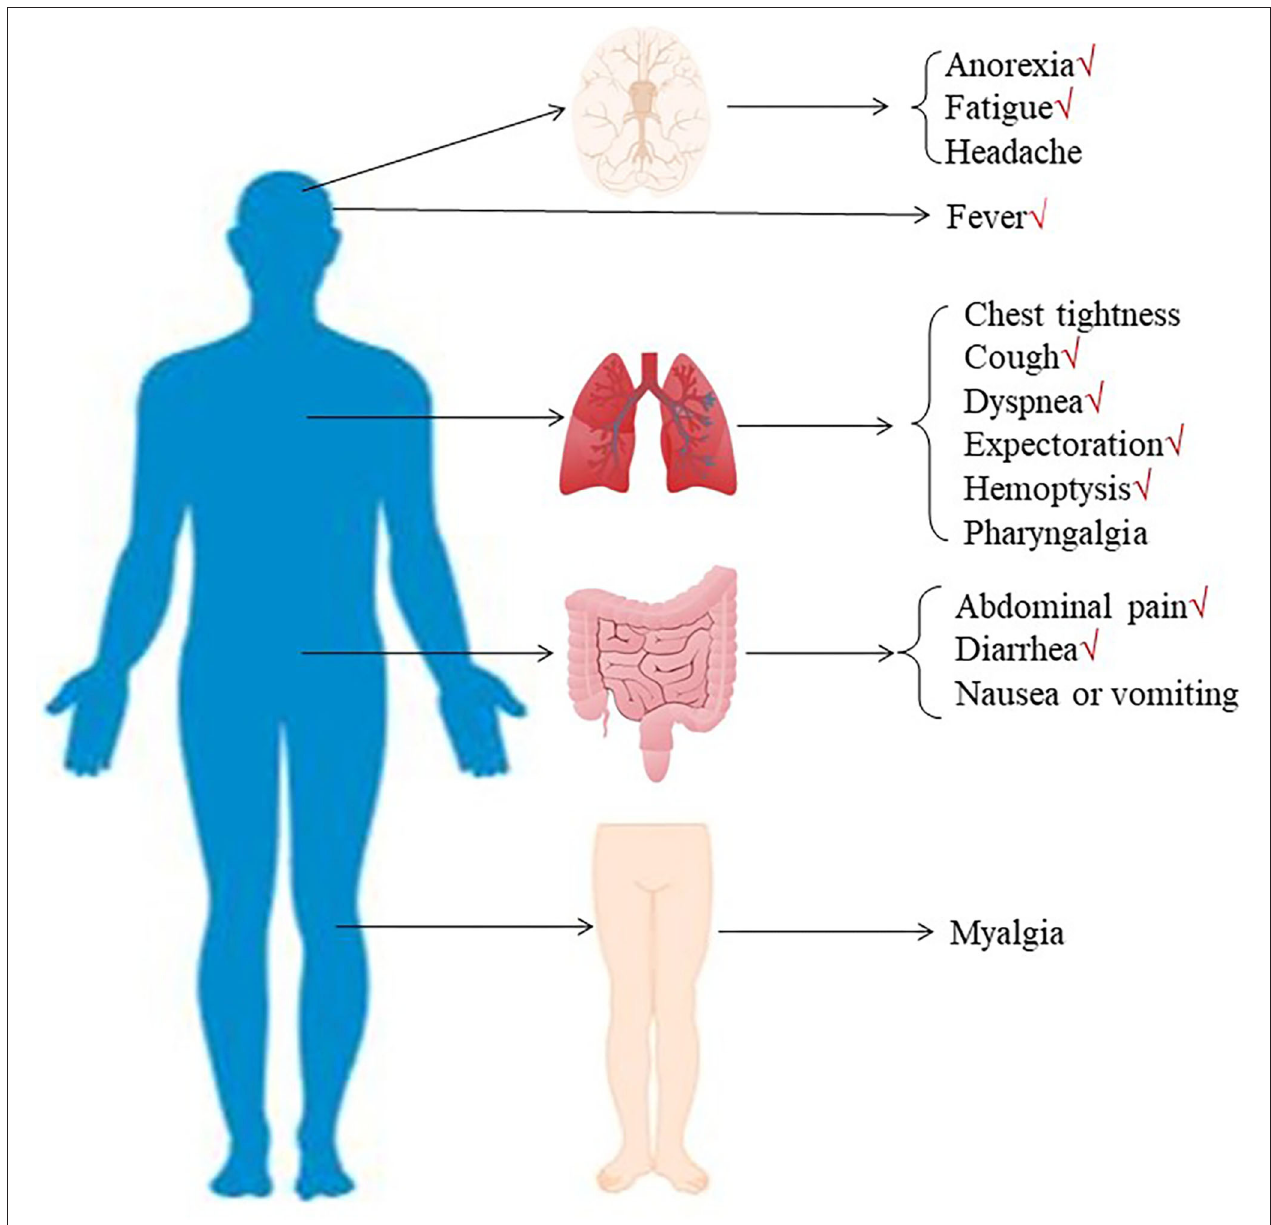
FIGURE 3 | The initial symptoms were divided into three types: respiratory symptoms (including fever, cough, dyspnea, expectoration, hemoptysis, chest tightness, and pharyngalgia), digestive symptoms (including abdominal pain, diarrhea, and nausea or vomiting), and neurological symptoms (including anorexia, fatigue, myalgia, and